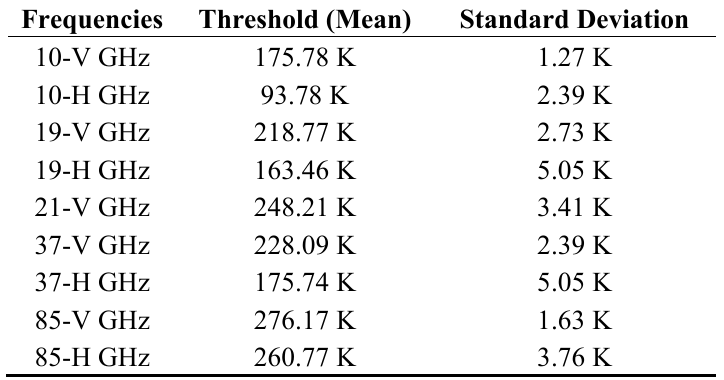
Figure 8. Histograms of the TB for the TMI in the absence of rain at 85 GHz: ( a ) TB10V and ( b ) TB10H. Table 1. Precipitation thresholds and standard deviations for TMI